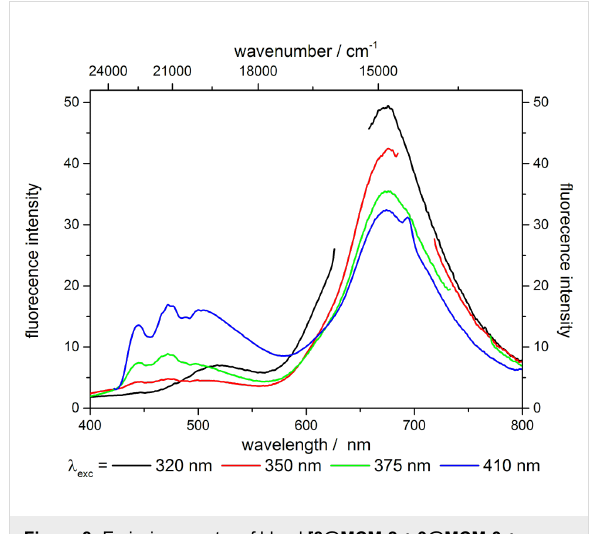
Figure 8: Emission spectra of blend [8@MCM-2 + 9@MCM-3 + 10@MCM-6]-1 at different excitation wavelengths (2nd order of excita- tion beam not